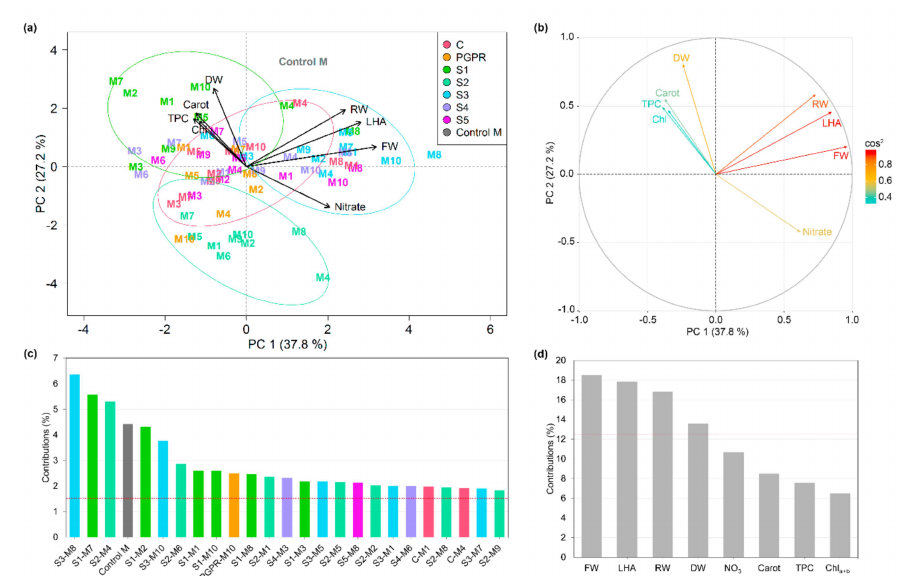
Figure 4. Principal component analysis (PCA) of the lettuce yield and quality variables under di ff erent BCI-plant growing medium treatments. ( a ) PCA biplot of individual samples to PC 1 and PC 2. Symbols indicate the type of plant growing medium (M1–10 and control M, the commercial plant growing medium) and colors indicate BCI treatment (S1–5, negative control C, and positive control PGPR). Ellipses denote 95% confidence interval of C, S1, S2, and S3. The plant performance parameters are shoot fresh weight (FW), lettuce head area (LHA), root fresh weight (RW), shoot dry weight (DW), total phenolic content (TPC), Nitrate content, chlorophyll a + b (Chl), and carotenoids (Carot); ( b ) Quality of representation (cos 2 ) correlation circle of variables to PC 1 and PC 2. The color gradient indicates the quality of representation of the variables; ( c ) Contribution plot of the top 25 samples to PC 1 and PC 2. Colors are the same as in a. The dashed line indicates the expected average contribution if the contribution of the samples were uniform; ( d ) Contribution plot of variables to PC 1 and PC 2. The dashed line indicates the expected average contribution if the contribution of the variables were